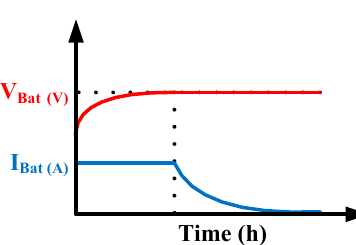
Figure 5. Representation of the two stages of the constant current followed by the constant voltage control algorithm.